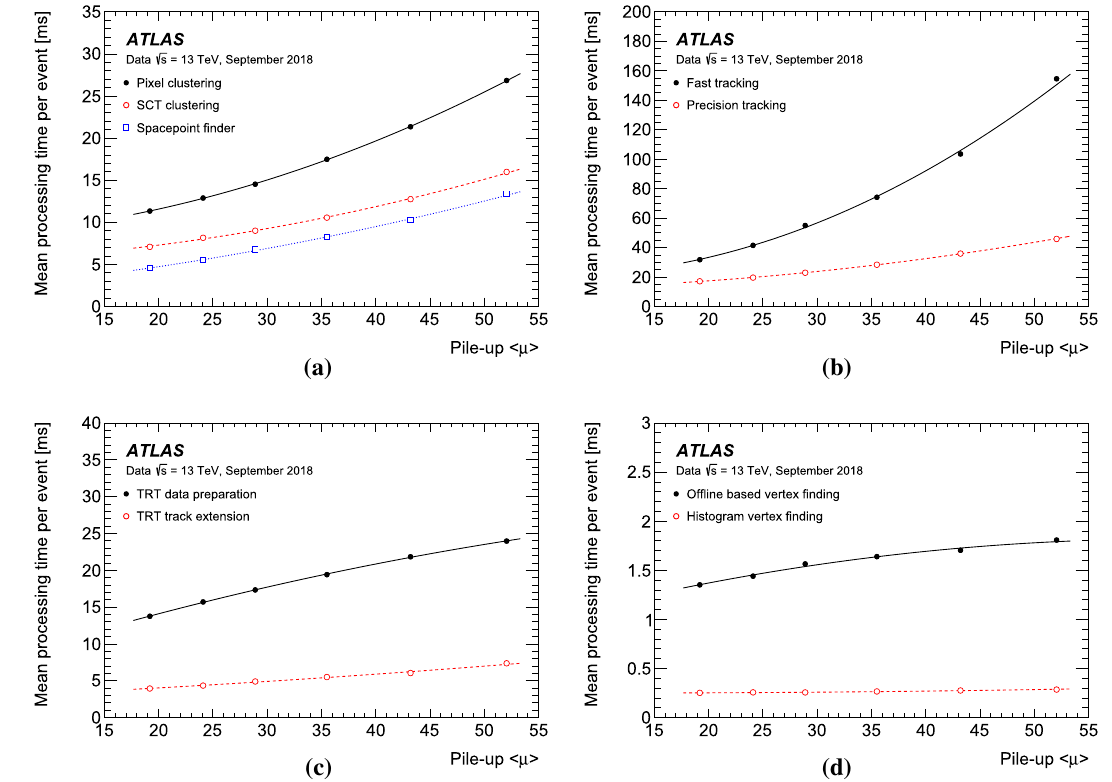
Fig. 16 The mean of the total processing time per event for the tracking related algorithms; a the data preparation for the silicon detectors, b the fast, and precision tracking, c the TRT data preparation and track extension, and d the